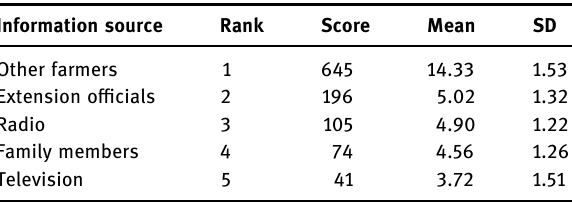
Table 3: Information source used by respondents for